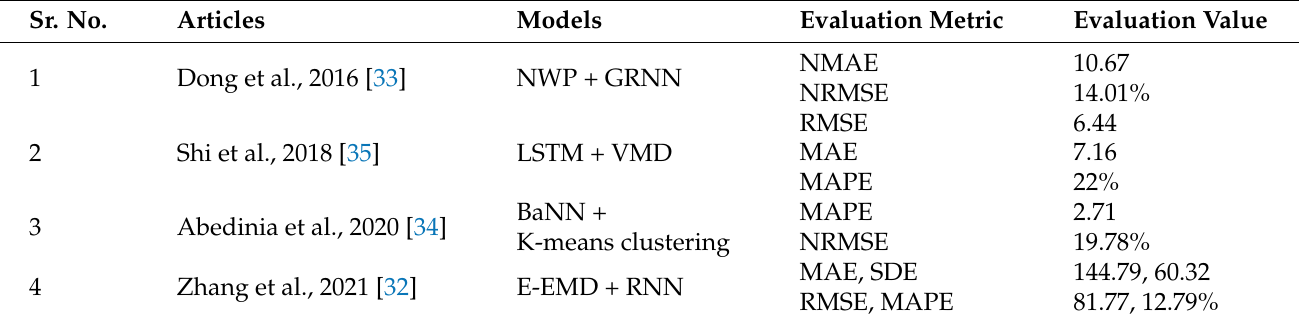
Table 5. Hybrid methods for long term